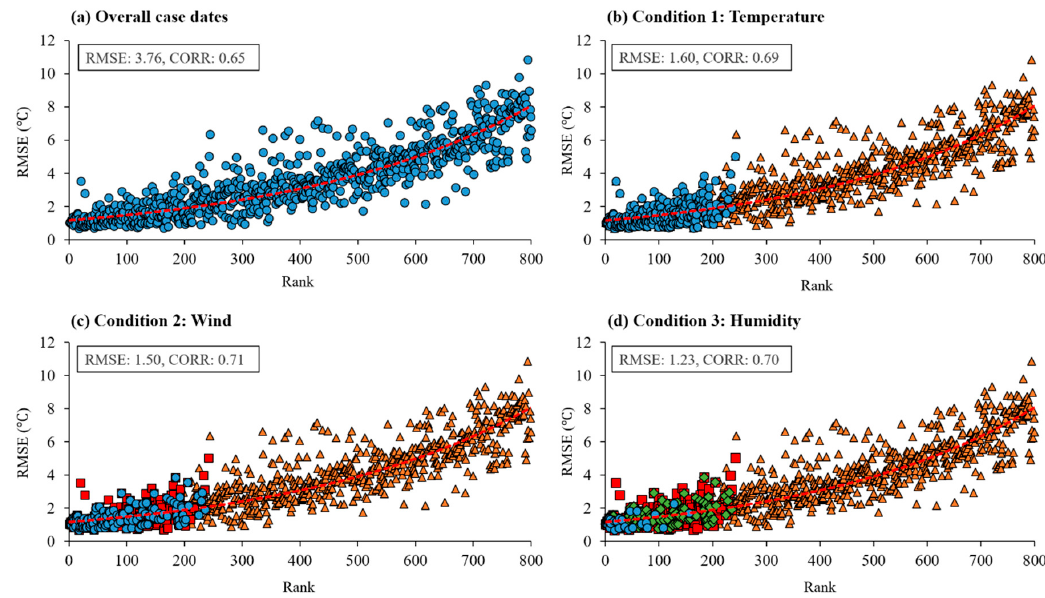
Figure 5. Rank according to Euclidean distance computed from prediction parameters (x-axis). Root mean square error (RMSE) computations of case dates depending on the Euclidean distance (y-axis). ( a ) Overall case dates (blue), filtering conditions applied to each parameter; ( b ) temperature (orange); ( c ) wind (red); and ( d ) relative humidity (green) .